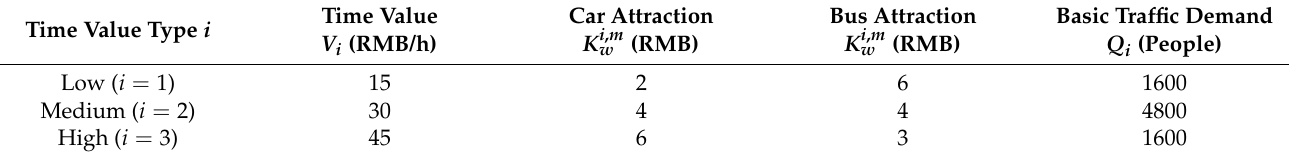
Table 4. Traveler information.